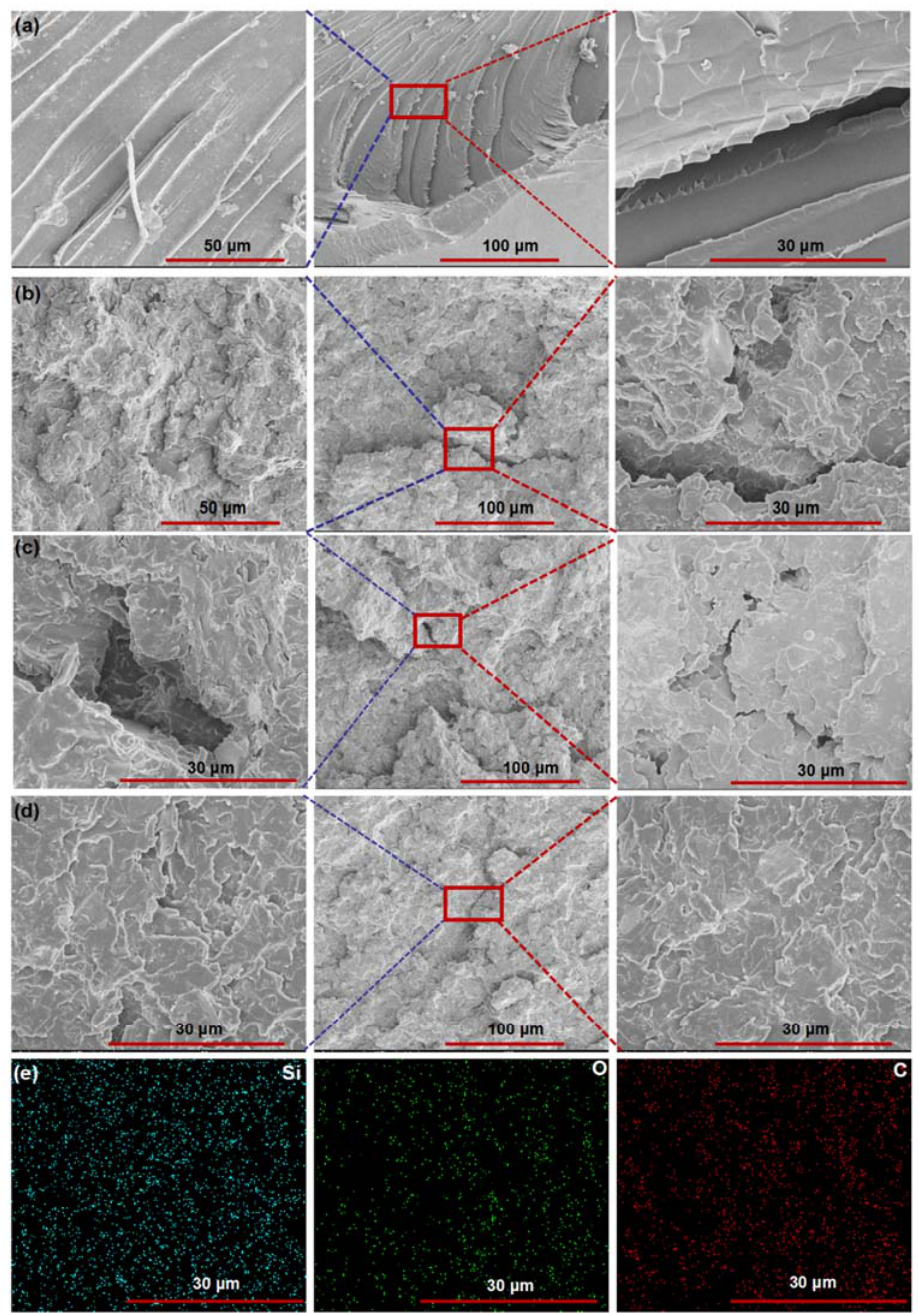
Figure 6. Morphology of the neat EP and its composites. Fractured surfaces of pure EP and QP–EP composites. ( a ) Pure EP; ( b ) QP–EP composites; ( c ) APTES–QP–EP composites; and ( d ) dual SCA– QP–EP composites. ( e ) Energy ‐ dispersive spectroscopic mapping images of Si, O, and C on the QP– APTES–SPIS–EP composite surface.